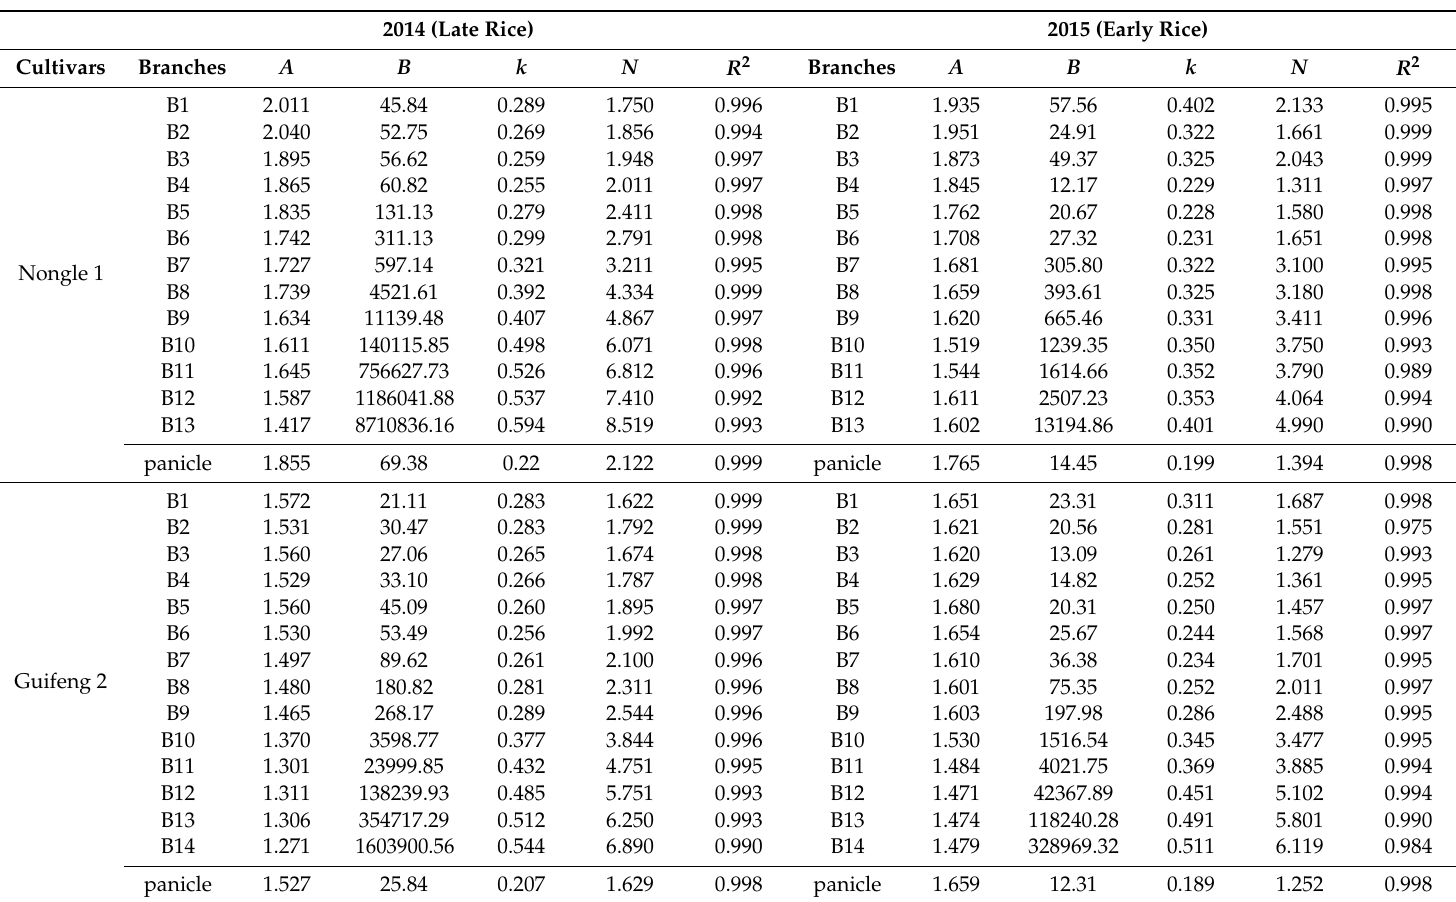
Table 1. Parameters of Richards equation for fitting grain growth of primary branches and the whole panicle of Nongle 1 and Guifeng 2 in 2014 and 2015. B1 to B14 represent the 1st primary-branch grains to the 14th primary-branch grains from the top to the base of the panicle for Nongle 1 and Guifeng 2. Panicle indicates the whole panicle of Nongle 1 and Guifeng 2. A is the final grain weight (g per 100 grains). B , k and N are the parameters set by the regression equation. k is the parameter of growth speed, B and N do not have the obvious biological meaning but they can decide flexibility and position of the growth curve. R 2 is the determinant coe ffi